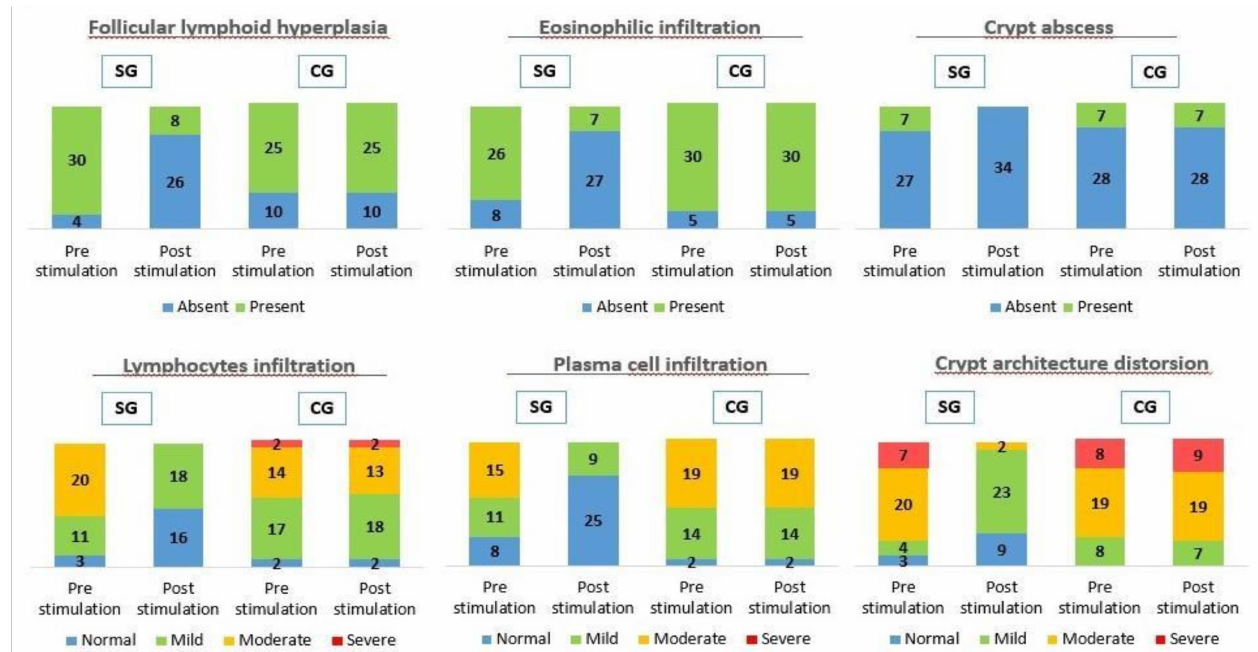
Figure 3. Microscopic findings by histological study before and after stimulation in CG and SG in diversion colitis. A statistically significant decrease in histologic pathological findings (follicular hyperplasia, eosinophils, cryptic abscesses, lymphocyte infiltration, plasma cell infiltration and architecture distortion) were observed in SG, with a p <